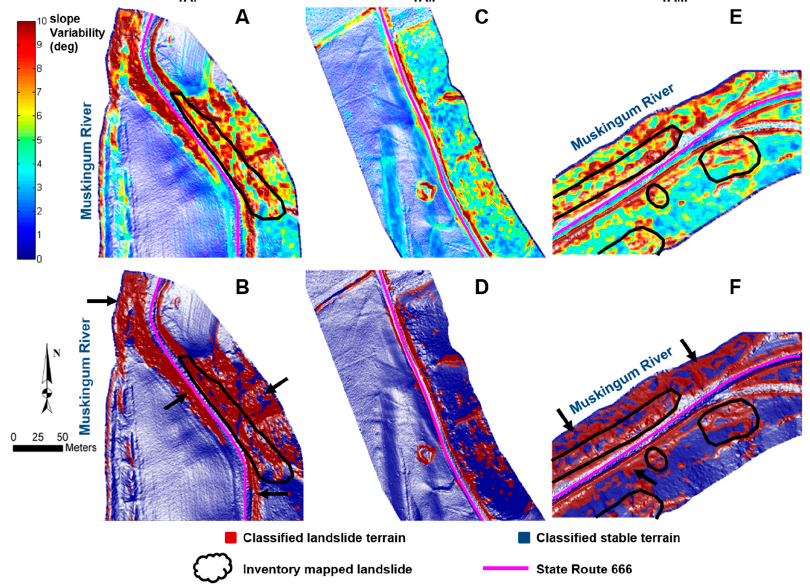
Figure 8. Illustrated in ( A , C , E ) are the surface roughness maps and in ( B , D , F ) are the classified maps for TAI, TAII and TAIII, respectively. Examples of overclassified areas are depicted by black arrows.